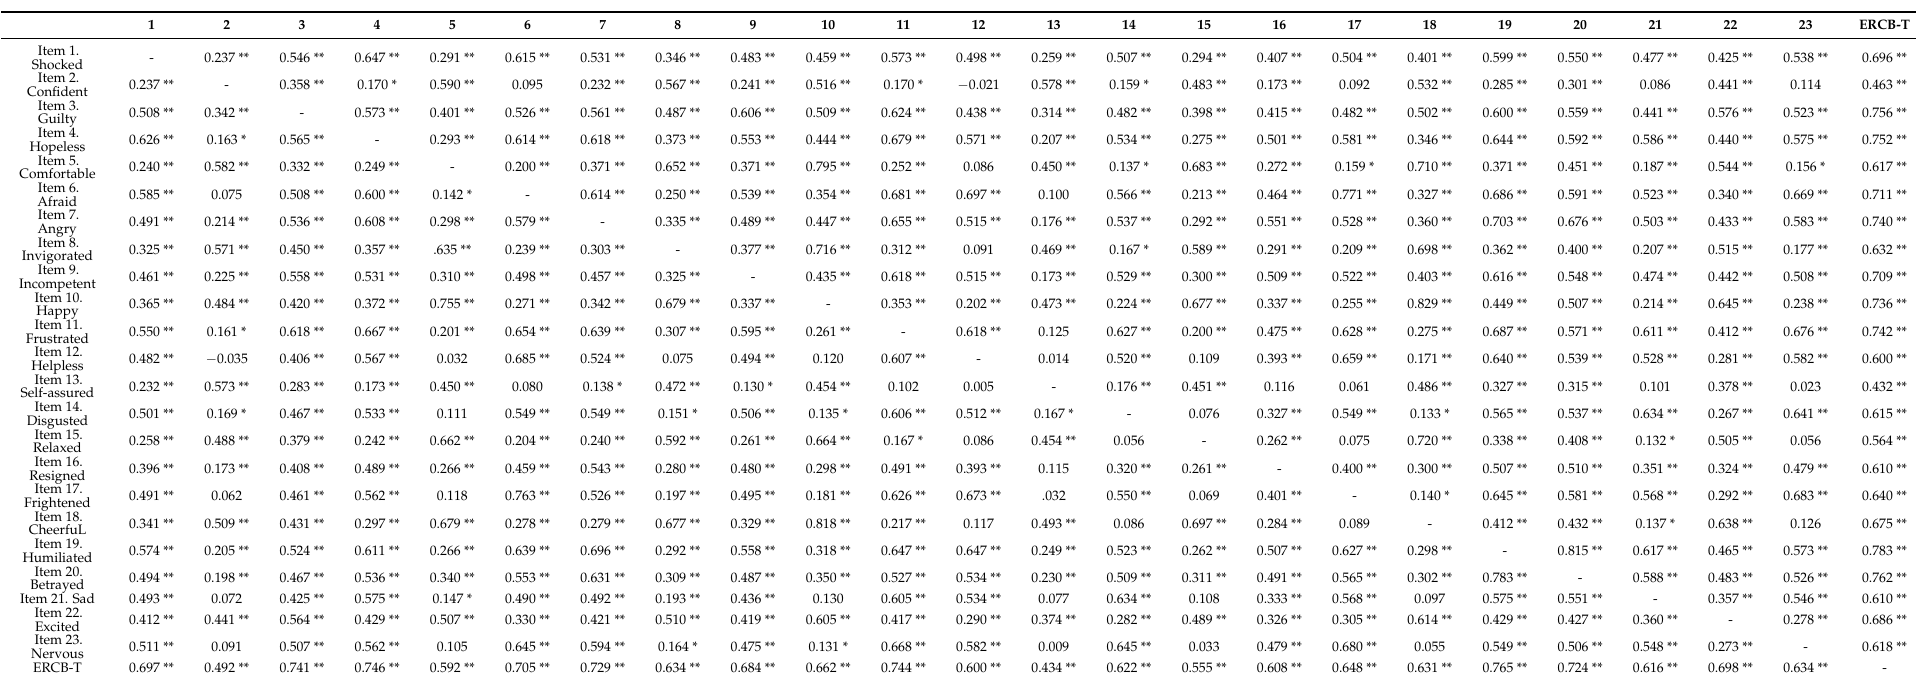
Table 2. Inter-item